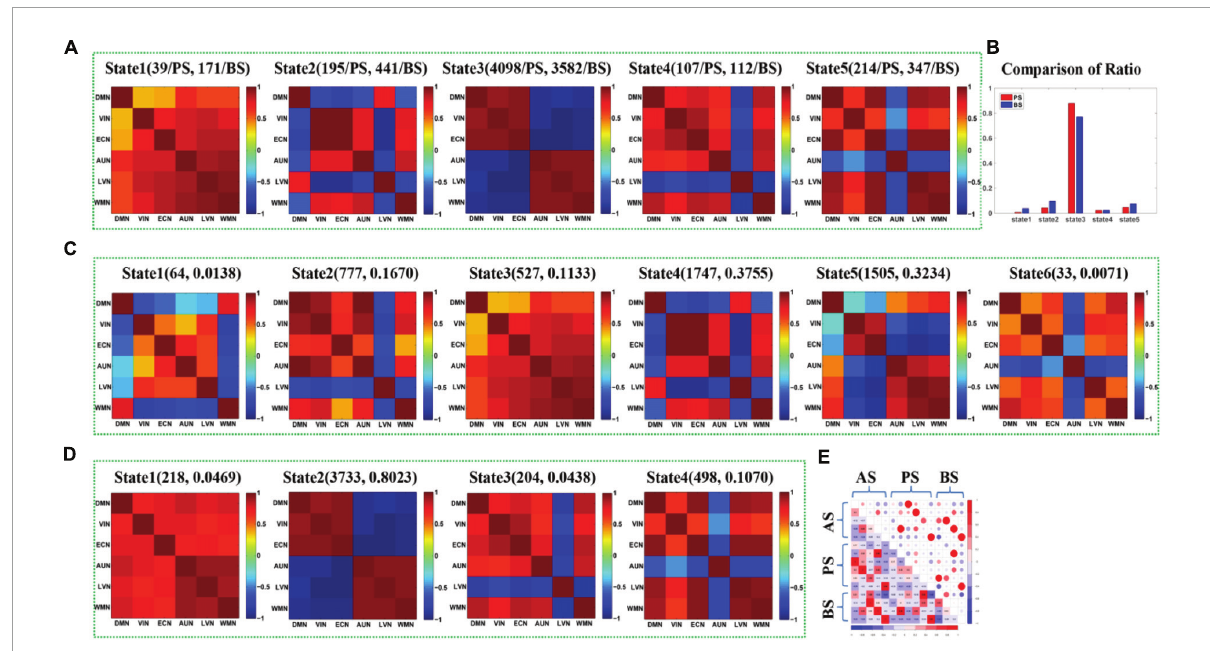
FIGURE6 (A) The maps of five DFC states (State1-State5) extracted from the DFCs of presailors and backsailors at the individual level, and the digits in parentheses on the top of each subfigure represent the number of DFCs contained in this state for presailors (PS) and backsailors (BS), respectively; (B) The histogram of proportion of the DFCs number corresponding to presailors and back-sailors contained in each state of (A), respectively; (C) The maps of six states (State1-State6) extracted from the DFCs of presailors at the individual level, and the digits in parentheses on the top of each subfigure represent the number and ratio of DFCs contained in this state; (D) The maps of four DFC states (State1-State4) extracted from the DFCs of back-sailors at the individual level, and the digits in parentheses on the top of each subfigure represents the number and ratio of DFCs contained in this state; (E) the correlation diagram between the three groups of DFC states in (A,C,D) .